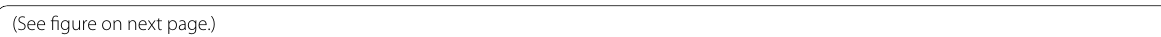
Fig. 4 Targeting relationship was identified between G6PD and miR-1-3p. a Three miRNAs (hsa-miR-1-3p, hsa-miR-206 and hsa-miR-613) targeted G6PD in gastric cancer was screened according ENCORI, TargetScan v7.2 and HMDD v3.2 databases. b RT-PCR assay was performed to detect the expression level of these three miRNAs in gastric cancer tissues and paracancerous tissues. N 77; * P < 0.05, ** P < 0.01 compared to adjacent tissues . = c The miR-1-3p expression level in gastric cancer cell lines (AGS and MGC-803) and gastric epithelial cell line (GES-1). N luciferase reporter assay in 293 T cell. N 3; ** P < 0.01 compared to mimics NC group; ## P < 0.01 compared to inhibitor NC group. e The effect = of miR-1-3p on G6PD mRNA and protein expression in AGS and MGC-803 cells was verified by qRT-PCR and western blot assay.